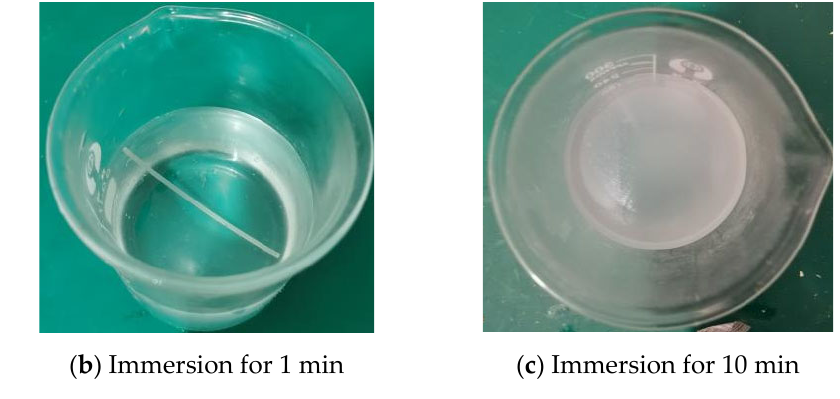
Figure 8. Water immersion of PVA materials.